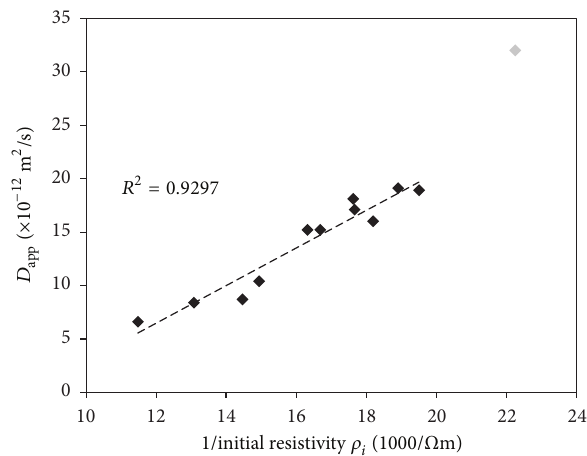
Figure 15: Correlation between inverse of average initial electrical resistivity and apparent chloride diffusion coefficient for all concrete types. The grey data point was not taken into account for linear